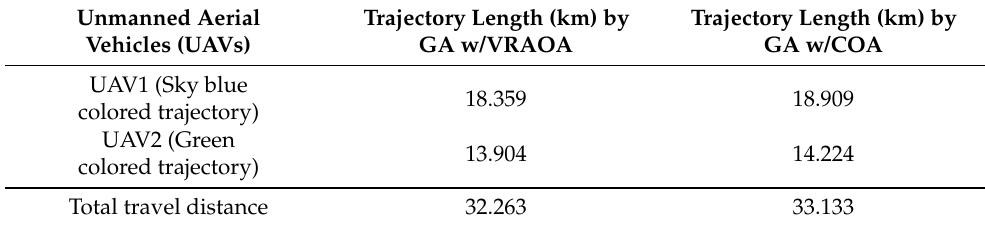
Table 3. Trajectory length of the